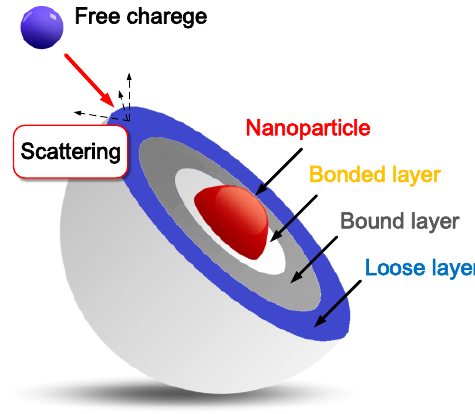
Figure 13. Multicore model and scattering of nanoparticles.